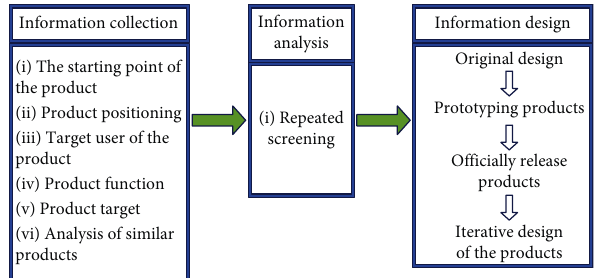
Figure 7: Artwork information design